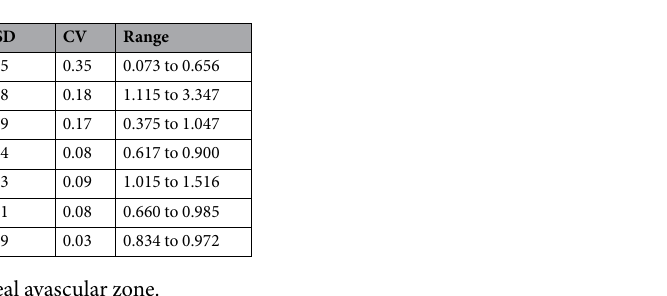
Table 2. Parameters of the foveal avascular